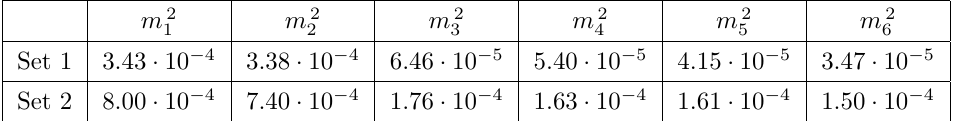
Table 4 . The canonically normalized masses squared after the uplift remain positive. This shows that the de Sitter vacua under investigation are